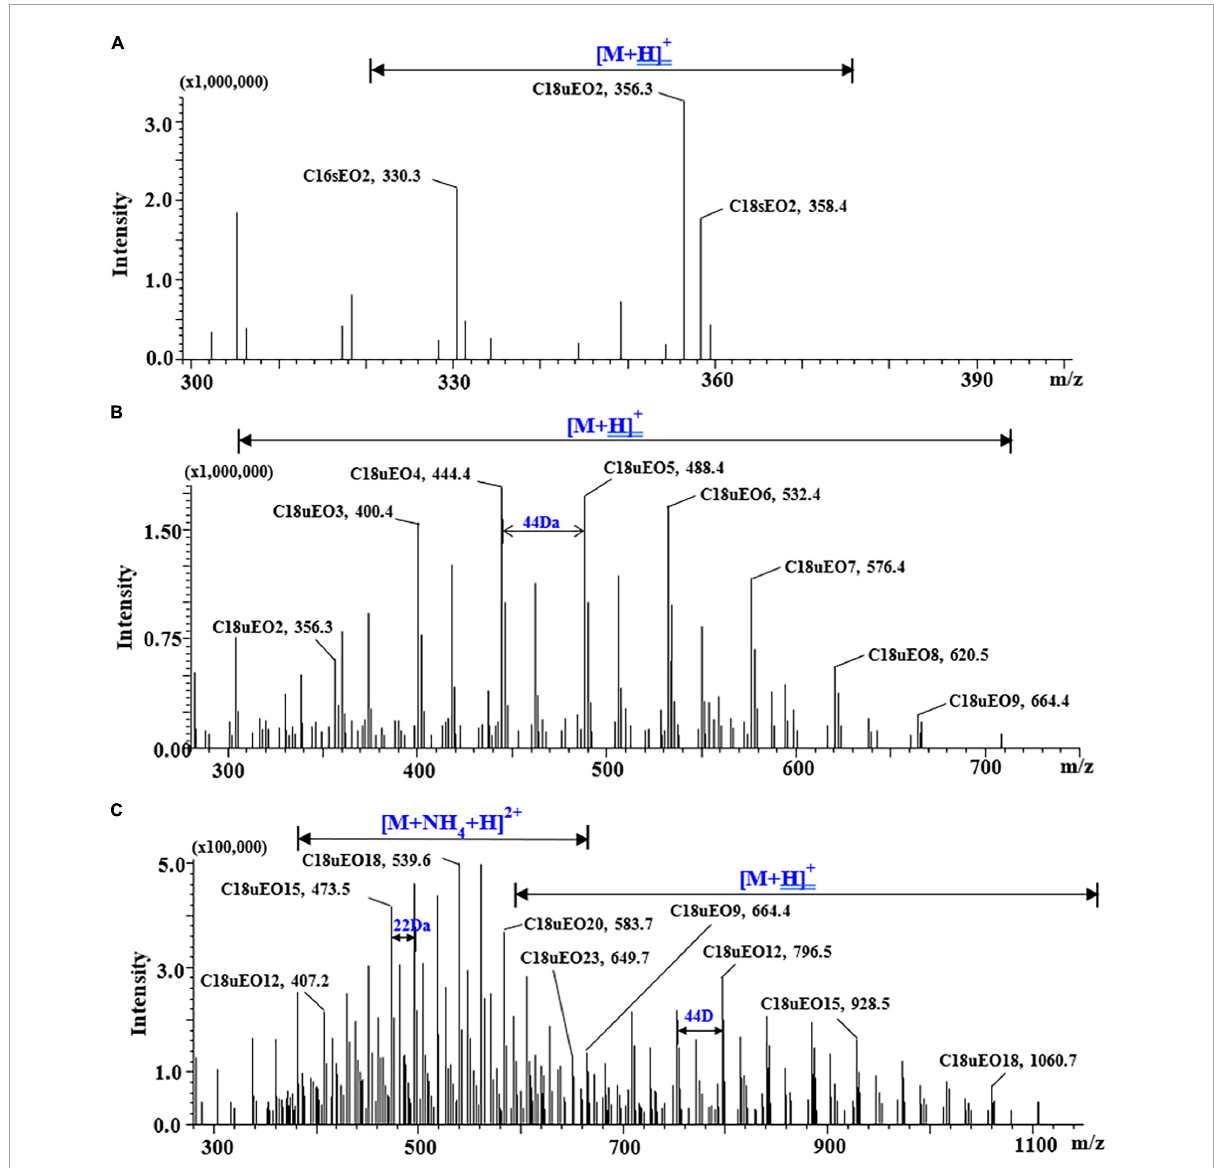
FIGURE1 Mass spectrum of standard polyethoxylated tallow amine (POE-tallowamine) by using ultrahigh-performance liquid chromatography-mass spectrometry (UHPLC-MS). (A) POE-2 (0.5 mg/L), (B) POE-5 (1 mg/L), and (C) POE-15 (5